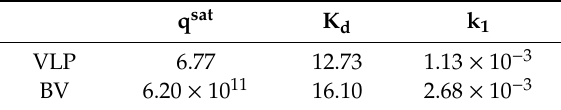
Figure 4. Batch uptake experiments at different feedstock concentrations. ( a ) C 0 = ¼ C feedstock ; ( b ) C 0 = ½ C feedstock ; ( c ) C 0 = ¾ C feedstock ; ( d ) C 0 = C feedstock . All experiments were carried at constant solid/fluid ratio. The concentration of NaCl is all samples is 300 mM. C VLP = 51.5 ng mL − 1 ; 𝐶 (cid:3033)(cid:3032)(cid:3032)(cid:3031)(cid:3046)(cid:3047)(cid:3042)(cid:3030)(cid:3038)(cid:3003)(cid:3023) = 2.3 × 10 10 copies mL − 1 .